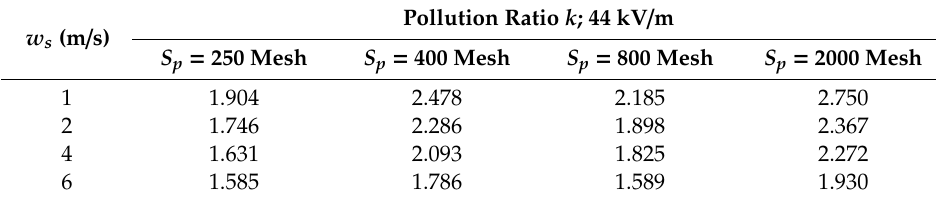
Table 7. Pollution ratio k under electrical stress of 44 kV / m.